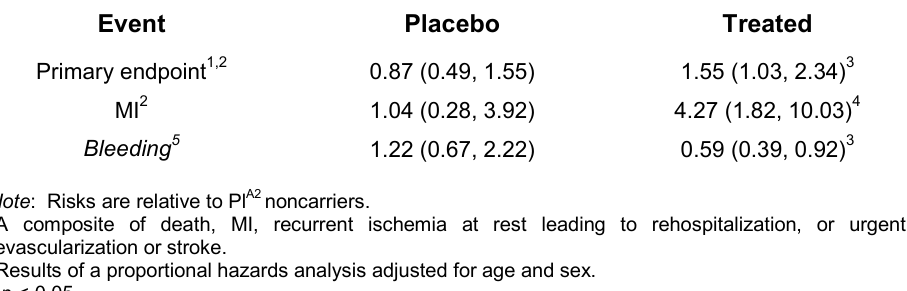
Relative Risk (95% Confidence Interval) for Primary End-Point, Myocardial Infarction, and Bleeding in Pl A2 Carriers According to